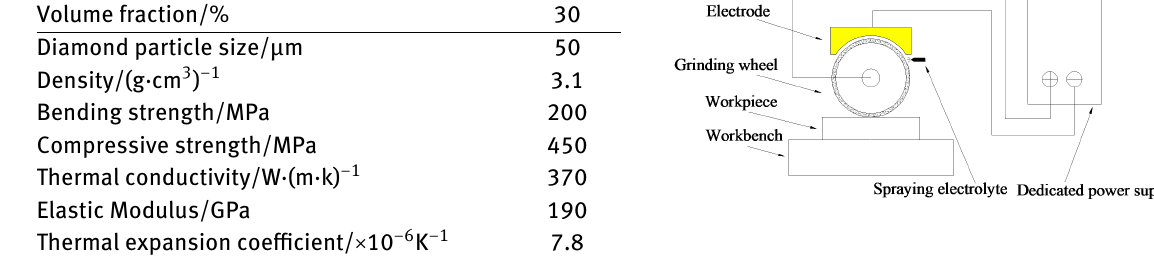
Table 1: Performance measurement data of materials Volume fraction/%